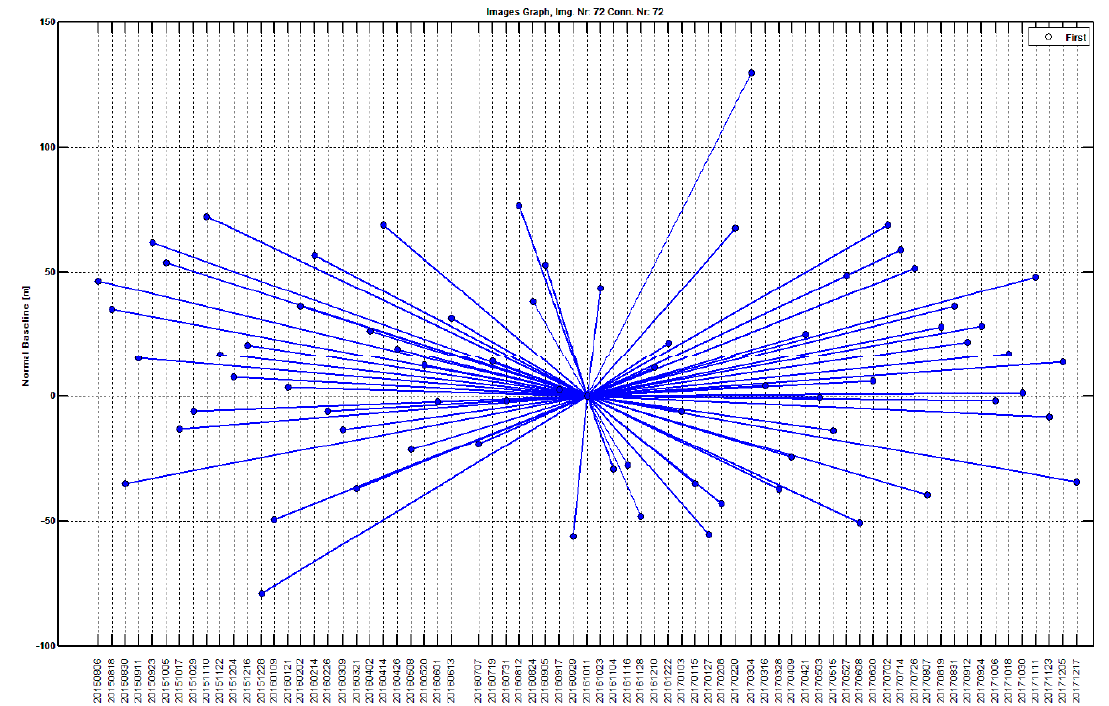
Figure 6. Star graph drawing showing the temporal / perpendicular baseline distribution of data pair of the orbit number 66. Blue lines represent the interferogram of two SAR acquisitions in blue dotes.